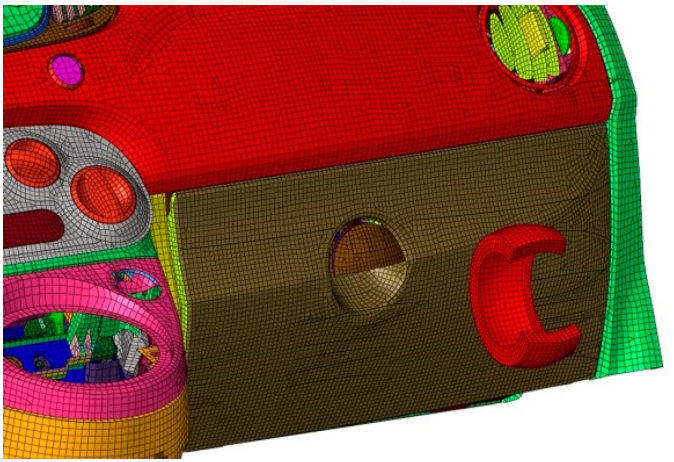
Figure 4. Subsystem test showing the impactor representing the knee.